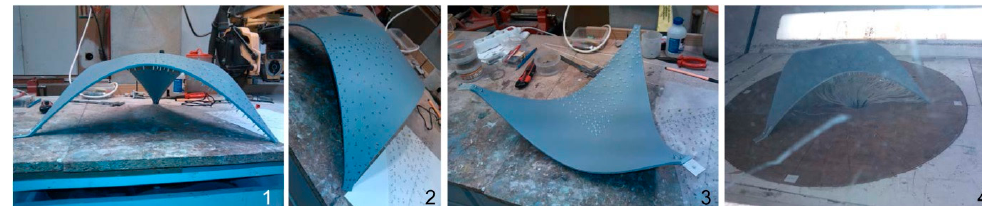
Figure 11. Installation of pressure sensors: ( 1 ) drilling; ( 2 ) painting with coating; ( 3 ) installation of pressure sensors; and ( 4 ) final instrumented model.